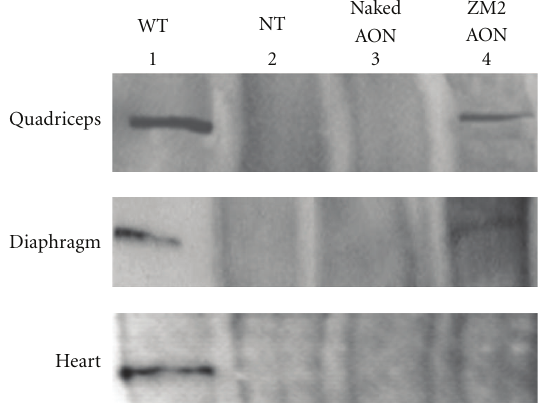
Figure 5: Western blot analysis. Immunoblotting for dystrophin using DYS2 antibody showed restored expression of the protein in the quadriceps and diaphragm of ZM2–AON-treated mice (lane 4), while no protein was detected in either untreated control (NT, lane 2) or naked AON-treated mdx mice (lane 3). Dystrophin protein was undetectable in the hearts of both untreated and treated mdx mice. Quadriceps, diaphragms, and hearts from WT mice were used as positive controls (lane 1). For WT samples, the total protein loaded was 1/10 (15 μ g) of the quantity in the other lanes (150 μ g). Quantification performed by densitometric analysis of autoradiographic bands followed by normalization with the quantity of total protein loaded onto the gel showed a dystrophin recovery of 8 ± 0.6% in quadriceps and 7 ± 0.17% in diaphragm ( P = 0 . 0002) of ZM2–AON-treated mice with respect to WT control mice. The results are representative of three separate experiments. Data are given as means ± S.E.M. and the statistical significance has been calculated with the Student’s t -test for unpaired